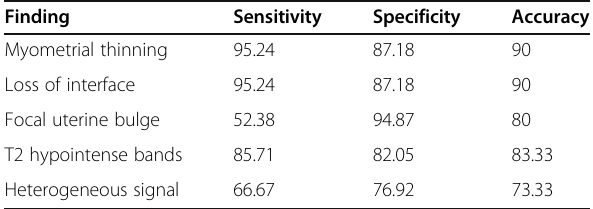
Table 2 Sensitivity and specificity of individual MRI findings in diagnosing placenta